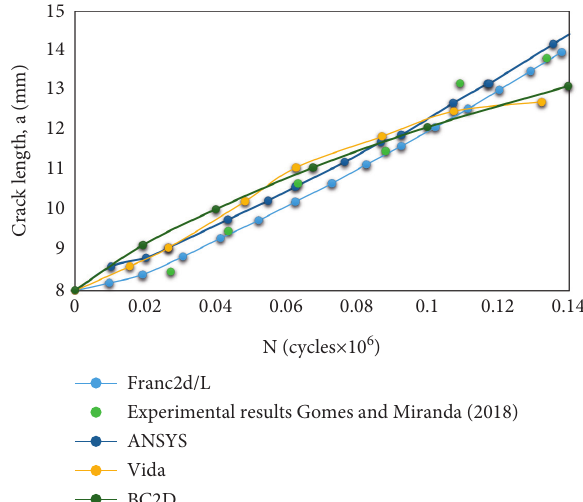
Figure 20: Comparison of the fatigue life and cracks length for the CTS04